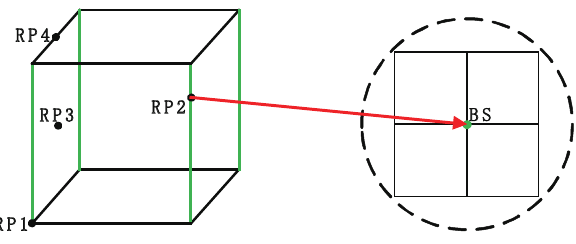
Figure 5. Schematic diagram of base-station Sharing-Value. the dotted circle on the right, there are also base stations with a sharing degree of 2.